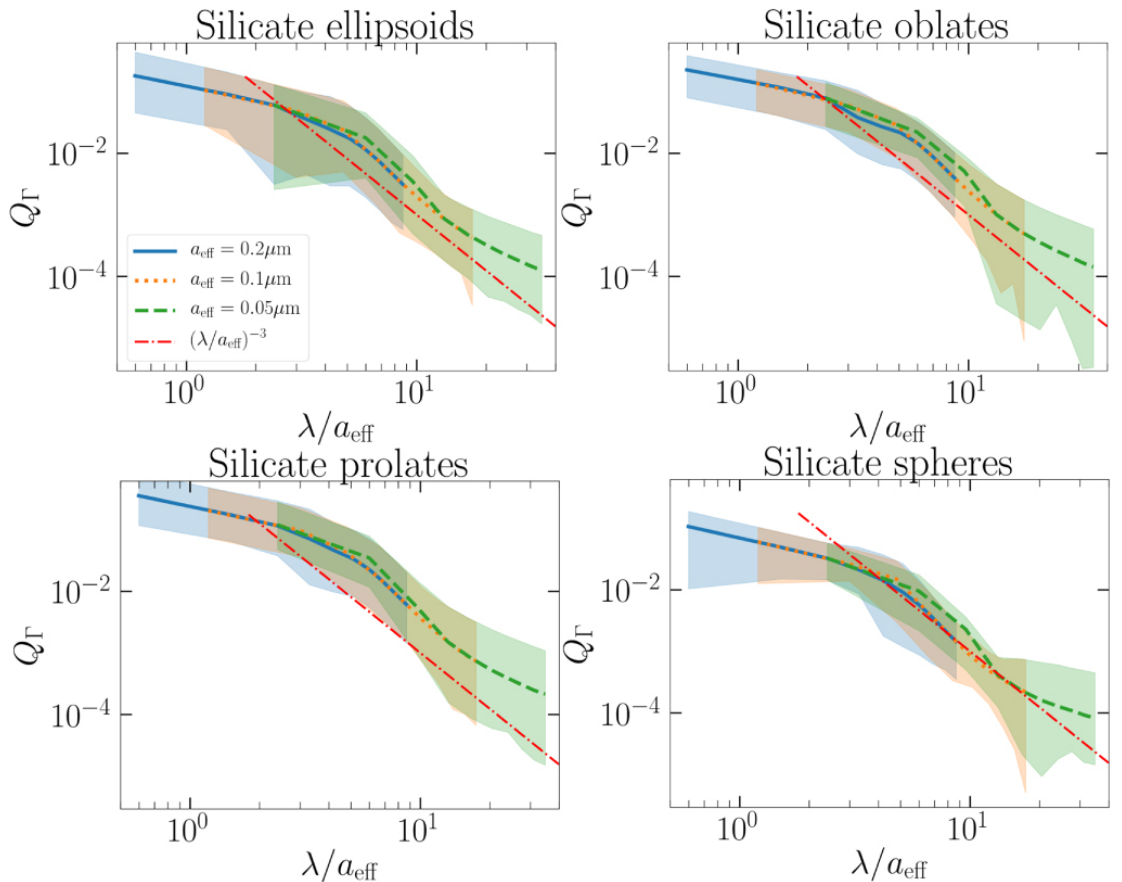
Figure 3. RATs computed by T-matrix method for the numerous grain shapes of silicate material from Herranen et al. [32]. A power-law fit to the numerical results of slope η = λ / a eff (cid:38)